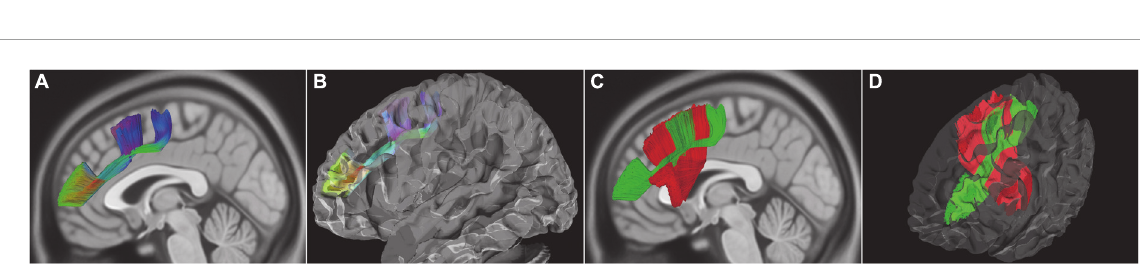
FIGURE5 In vivo fiber tractography of the FLF (HCP-842). (A,B) The FLF ran as a longitudinal course approximately beneath and parallel to the MFG. Some bundles of fibers originated from the anterior part of the MFG and the other bundle of fibers from the Ptr and then ended in the caudal MFG, caudal SFG, and dorsal PreG. (C,D) Spatial relationship of the FLF and FAT. The FLF was intersecting together with the FAT. FLF, frontal longitudinal fasciculi; MFG, middle frontal gyrus; SFG, superior frontal gyrus; Ptr, pars triangularis; PreG, precentral